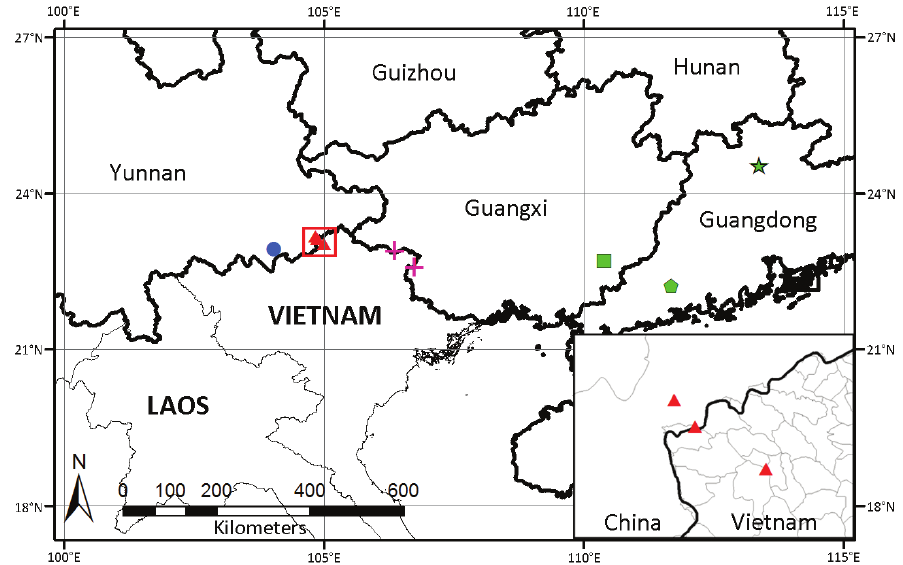
Figure 4. Geographical distribution of Primulina malipoensis (triangle), P. lungzhouensis (cross), P. ma- guanensis (dot), P. maculata (pentagon), P. beiliuensis var. beiliuensis (square) and P. beiliuensis var. fimbri- bracteata